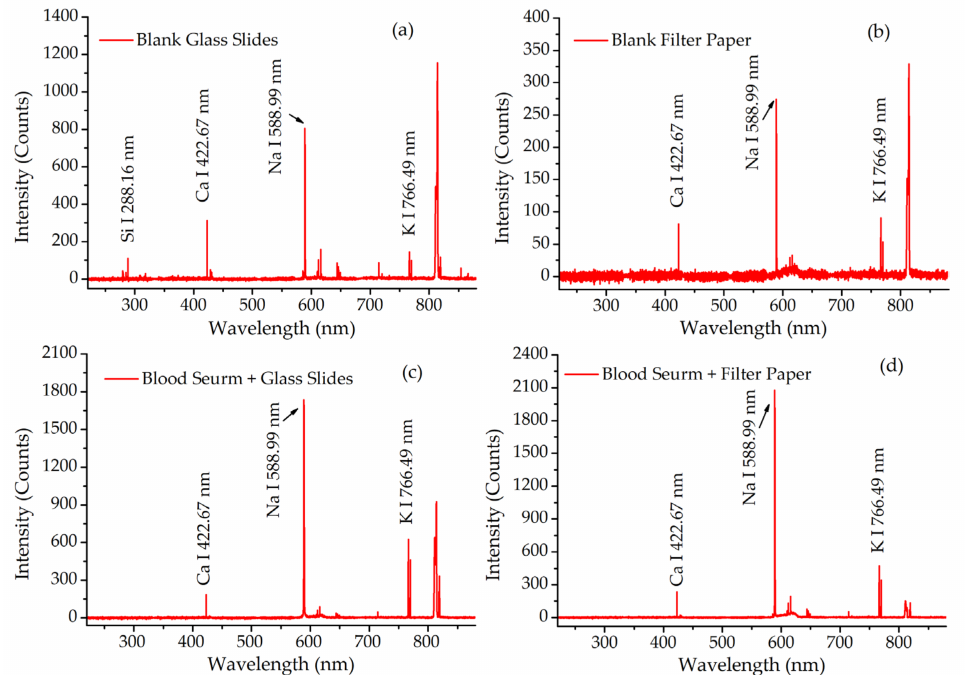
Figure 2. The LIBS spectra of samples and their blank supports. ( a ) Blank glass slides; ( b ) blank filter paper; ( c ) blood serum deposited on glass slides; ( d ) blood serum deposited on filter